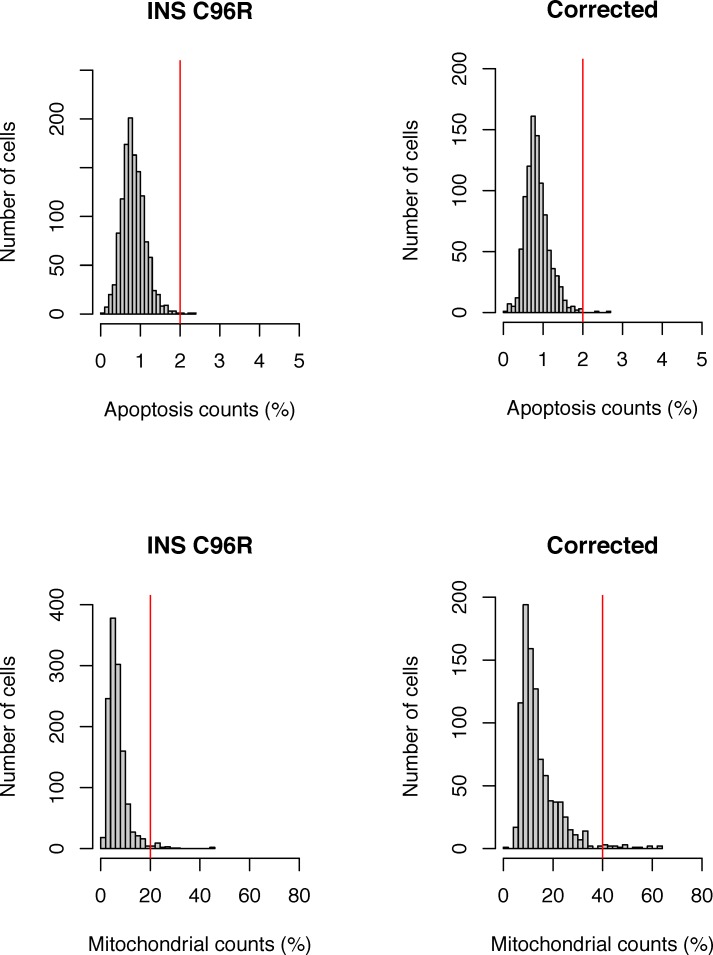
Single-cell RNA-seq quality control with mitochondrial and apoptosis count filters.(A) Distributions of mitochondrial counts per cell in mutant and corrected samples. (B) Distributions of apoptosis gene counts per cell in mutant and corrected samples. Cells with values above the threshold (red vertical line) were filtered out.